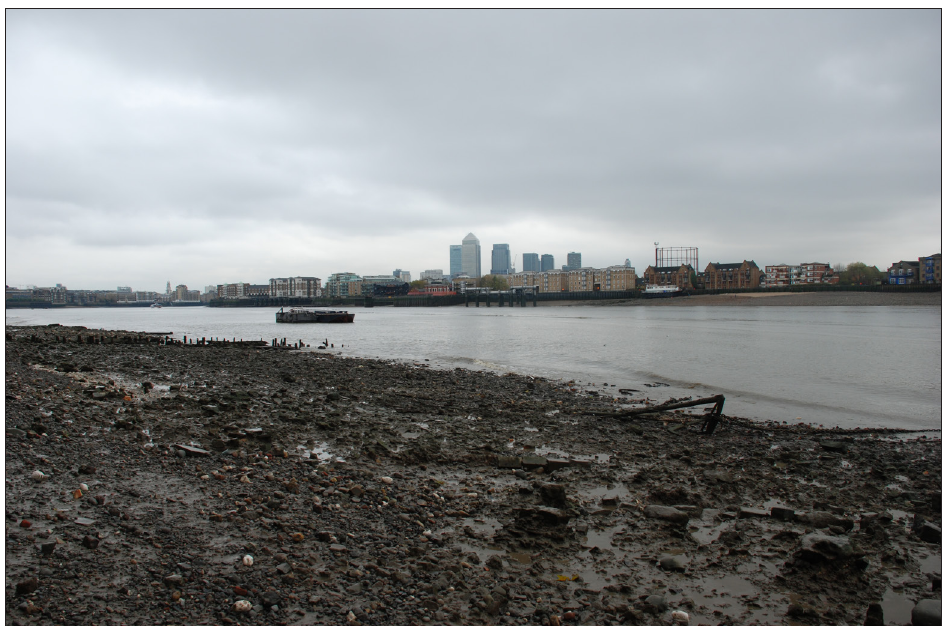
Figure 6: The Thames Foreshore, November